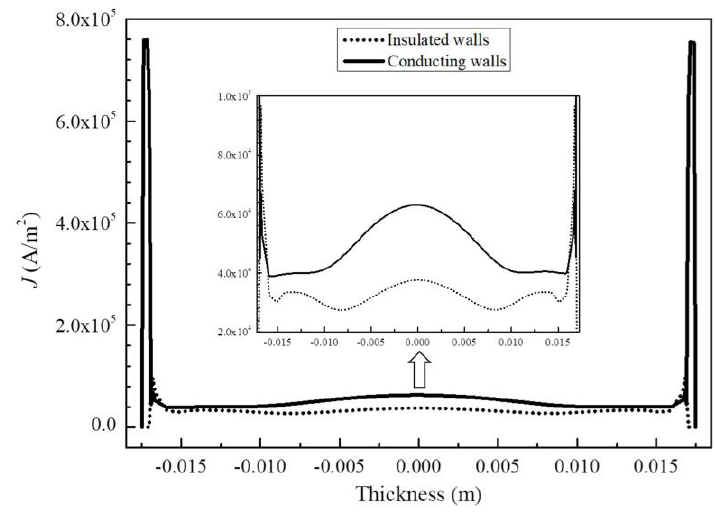
Figure 11. Time-averaged induced electrical current density distribution on line 4 (refer to Figure 10).